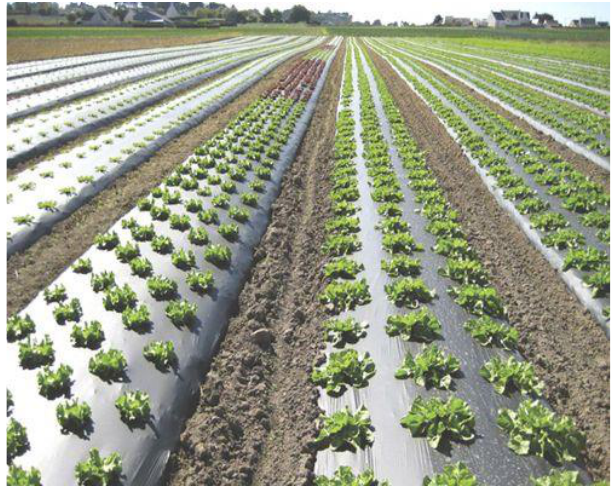
Figure 16. Black Mulch films. Reprinted from website [90].